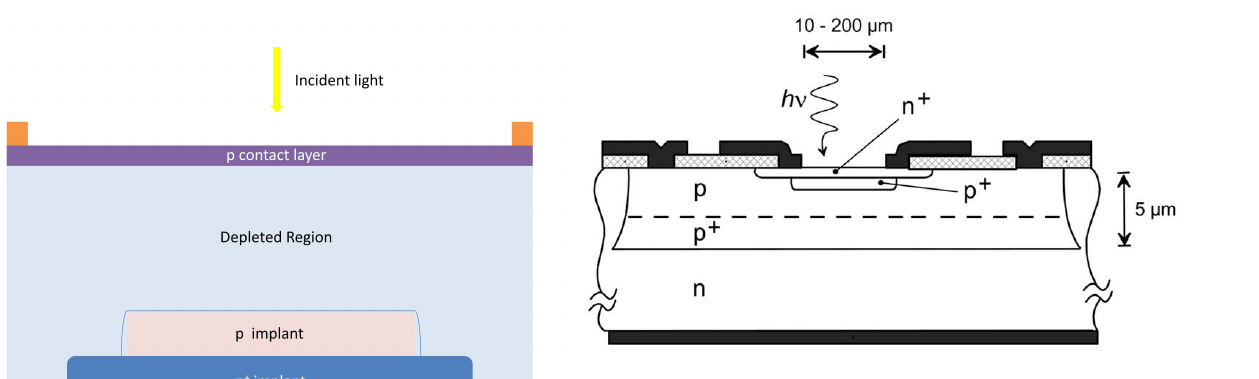
Figure 7: Planar epitaxial structure developed by Cova, et. al. The n + p + junction serves as the active region. The buried p + layer pro- vides a low-resistance path for avalanche current initiated by light absorbed in this region. The buried p layer serves as a guard ring to prevent edge breakdown. From